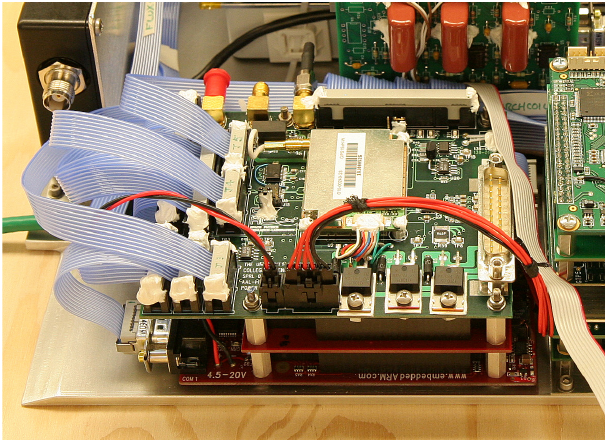
Figure 10. The PC-104 stack mounted on the electronics chassis. The custom I/O board is on the